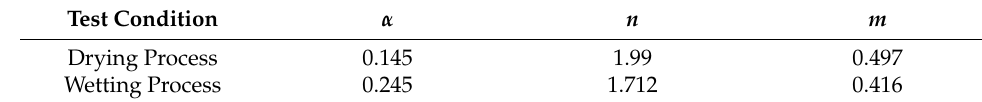
Table 2. Curve-fit parameters of the SWCC model (van Genuchten [30]).